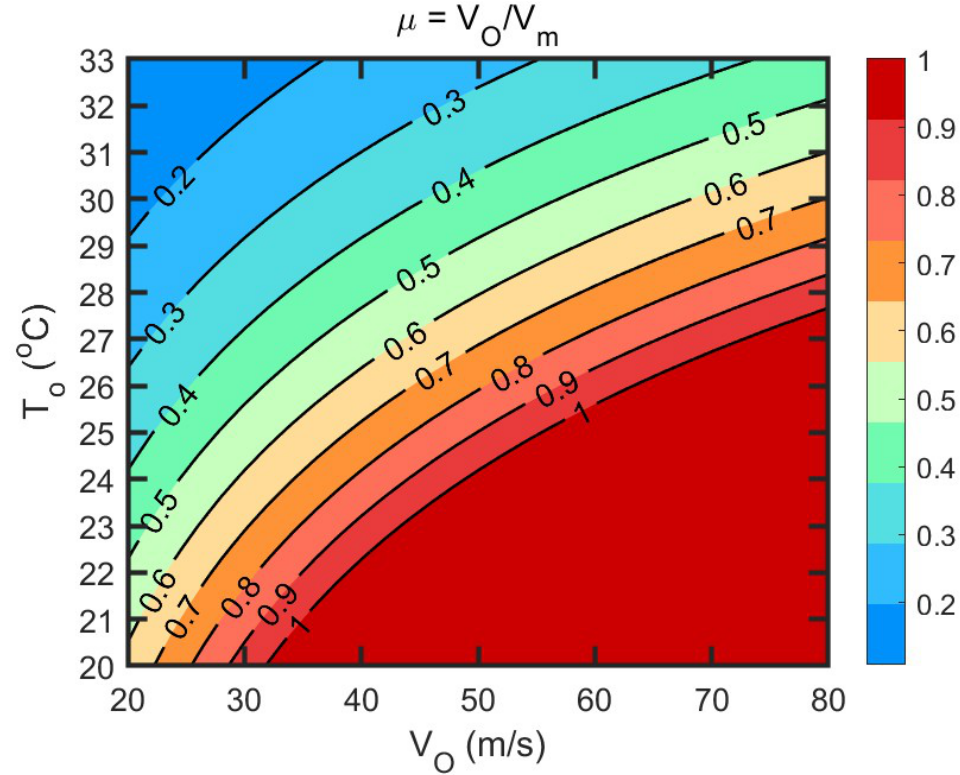
Figure 2. Plot of μ = V O /V m . Figure 2. Plot of µ = V